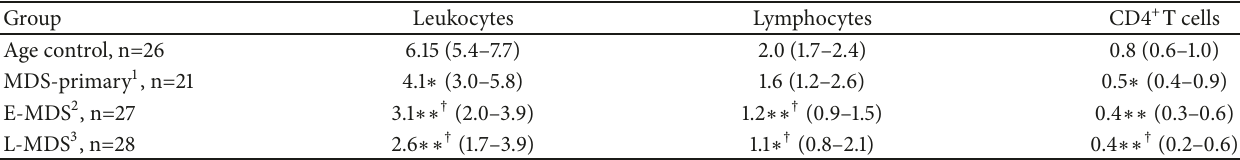
Table 3: The absolute number of cell populations in the peripheral blood of patients with MDS and age-matchedhealthy donors (10 9 cells/L). Group Leukocytes Lymphocytes Age control, n=26